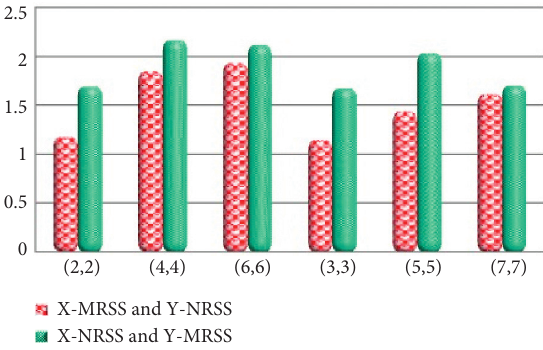
Figure 6: RE of SSR estimates at R � 0.8889.